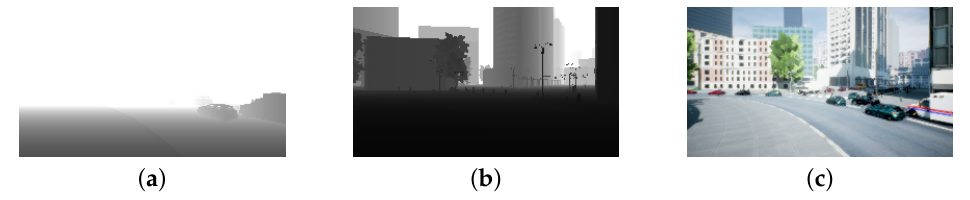
Figure 1. AirSim views: ( a ) Depth map (up to 10 m), ( b ) Depth map (up to 200 m), ( c ) Monocular (RGB) image of ( b